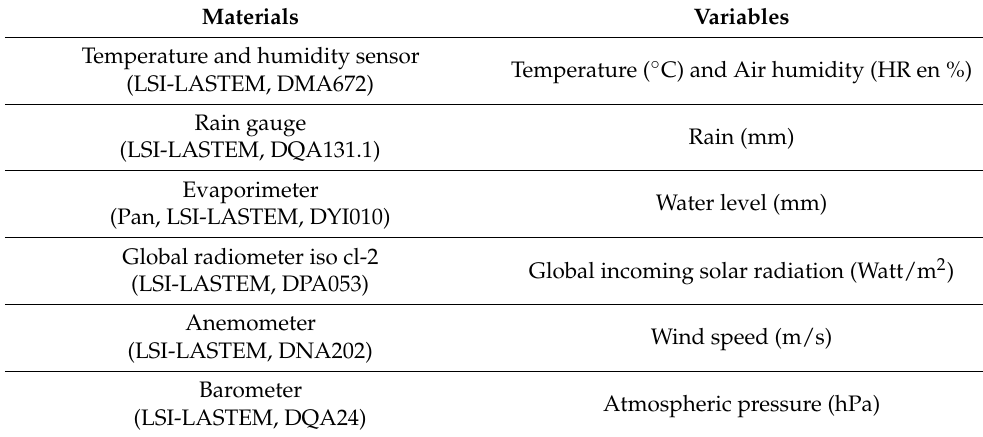
Table 2. Details of materials used for measuring meteorological